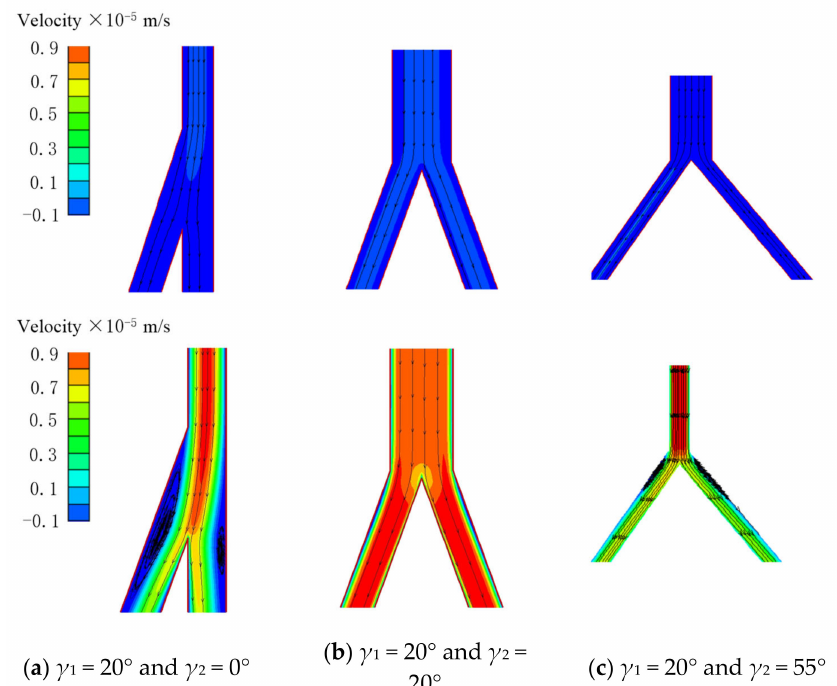
Figure 11. Flow velocity profiles for FFI at hydraulic gradient J = 0.01 (top row) and J = 0.3 (bottom row)